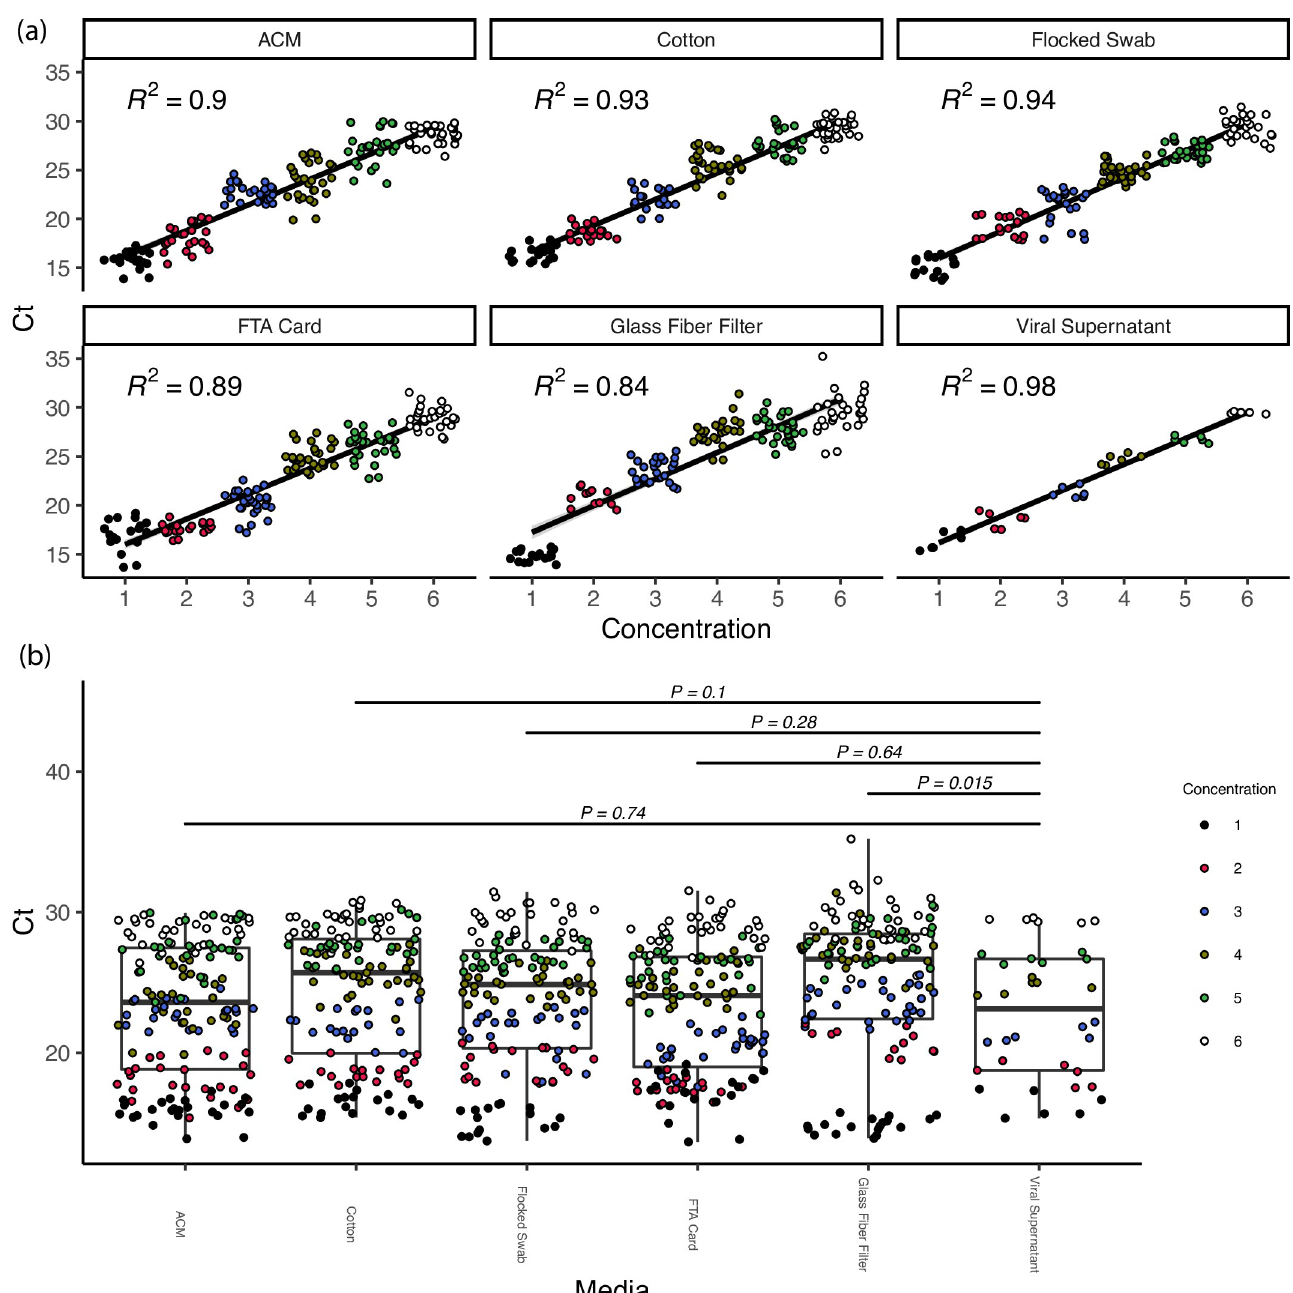
Fig 4. Bench series 1 results. Capture testing media results. (a) Measured Ct values across the serial dilution curve, ranging from 3.2 � 10 6 genome copies per μ L (concentration 1) to 3.2 � 10 1 genome copies per μ L (concentration 6) (b) Boxplots of measured Ct values of liquid eluted from capture media across all concentrations tested. Concentrations are the same as in